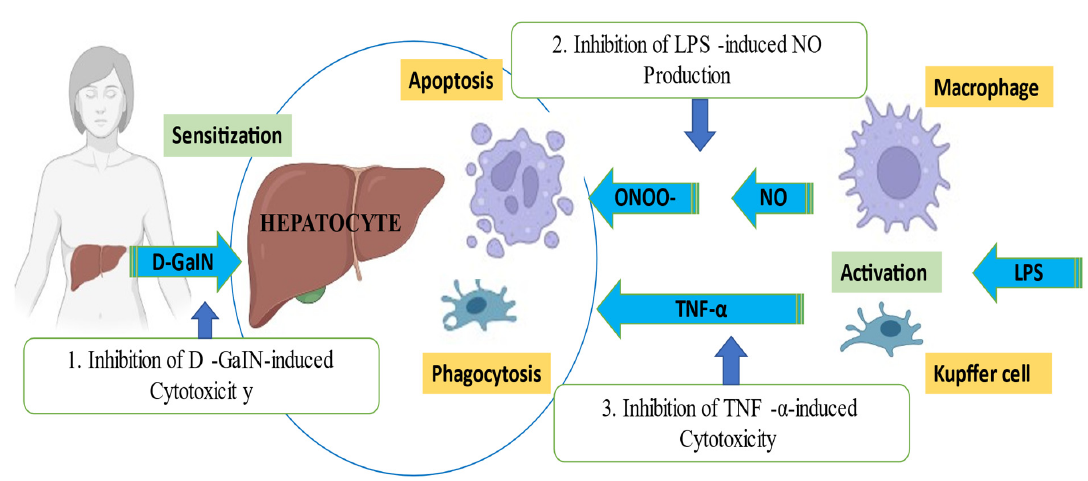
Figure 10. Anti-allergic, hepatoprotective and anti-in fl ammatory underlying mechanism. Hedycoronen A, Hedycoronen B, labda-8(17),11,13-trien-16,15-olide, 16-hydroxyl- abda-8(17),11,13-trien-15,16-olide, Coronarin A, and Coronarin E were isolated